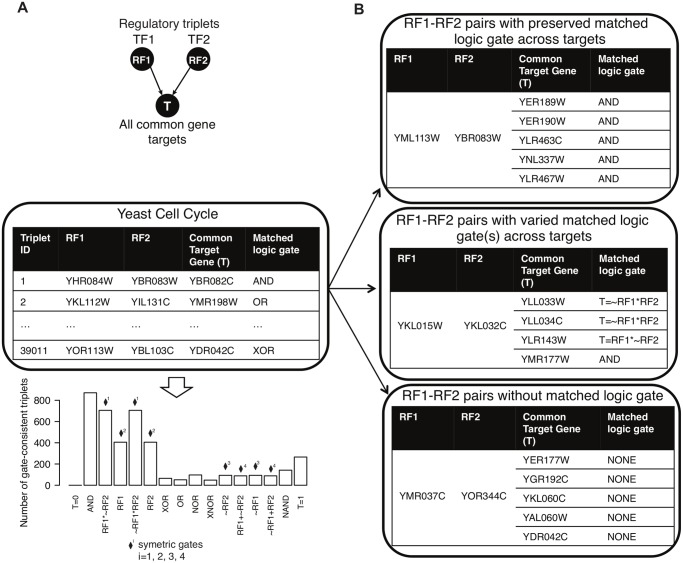
Cooperative logics found by Loregic for yeast regulatory triples.
A—Loregic gives for each triplet a matched logic gate as shown in the table. The bar plot shows the distribution of 4126 gate-consistent TF-TF-target triplets across matched logic gates. The symmetric gate pairs are marked using diamonds on top of bars with identical superscript numbers due to randomly assigning TFs as TF1 or TF2. B—Top: an example RF pair (RF1 is YML113W, RF2 is YBR083W) with “homogenous” gate-consistent triplets—matching the same, logic gate across all targets; middle: an example RF pair (RF1 is YKL015W, RF2 is YKL032C) with “inhomogeneous” gate-consistent triplets—matching different logic gates across all targets; and bottom: an example RF pair (RF1 is YMR037C, RF2 is YOR344C) with non-gate-consistent triplets, i.e. triplets inconsistent with all logic gates across all targets.